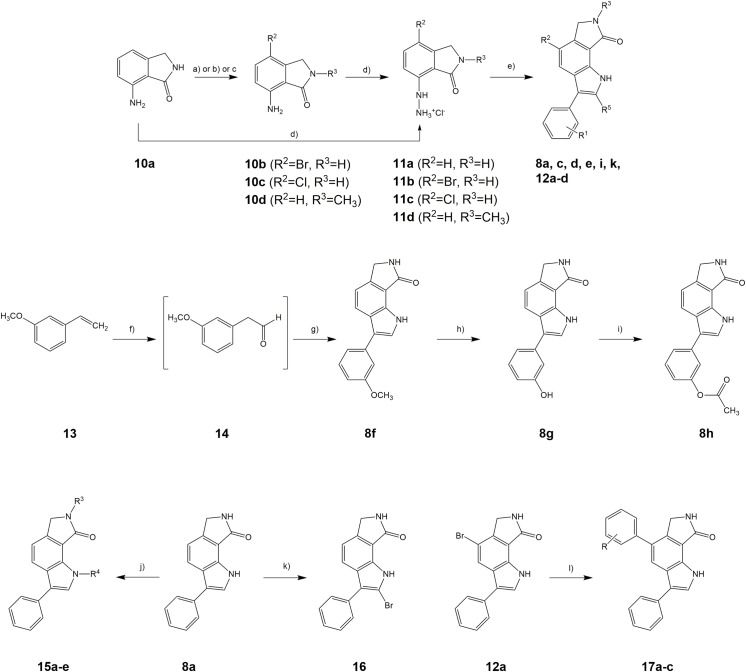
Synthesis procedures for 3-aryl-6,7-dihydropyrrolo[3,4-g]indol-8(1H)-ones.For residues R1-R5 refer to Table 1. Reagents and conditions: (reagents and conditions a, for synthesis of 10b) NBS, CH2Cl2, - 8°C, 1 h, 78%; (reagents and conditions b, for synthesis of 10c) NCS, acetonitrile, 60°C → reflux, 2 h, 81%; (reagents and conditions c, for synthesis of 10d) CH3I, KOtBu, THF, RT, N2, 24 h, 54%; (d) 1. 37% HCl, NaNO2, < 0°C; 2. 37% HCl, SnCl2 x 2 H2O, 30 min; (e) aldehyde or ketone or acetal, acetic acid, 95°C, 3.5 h, 10%-31%; (f) PdCl2(MeCN)2, p-benzoquinone, tert-butanol, water, 80°C; (g) 11a, ethanol, H2SO4, H2O, 50°C, 2.5 h, 23%; (h) BBr3, CH2Cl2, RT, N2, 1 h, 33%; (i) acetic anhydride, pyridine, 4-DMAP, RT, 3 h, 29%; (j) alkyl halide, KOtBu, acetone, RT, N2, 24 h, 15%-48%; (k) NBS, CH2Cl2/acetic acid, < 10°C, N2, 1.5 h, 29%; (l) appropriate arylboronic acid, Cs2CO3, toluene/ethanol, mircowaves, 150°C, 20 min, 5.4%-31%.